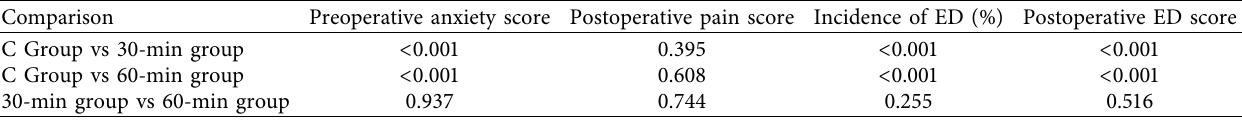
Table 3: p values of the inter-group comparison among the three